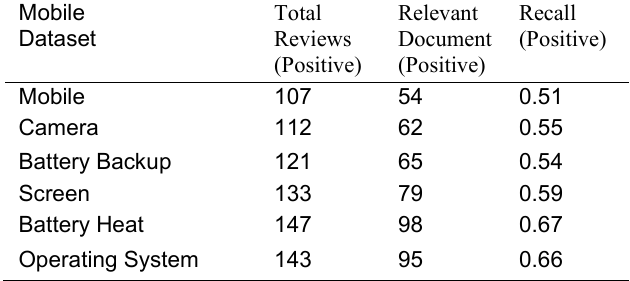
Table 6. Recall of FBA